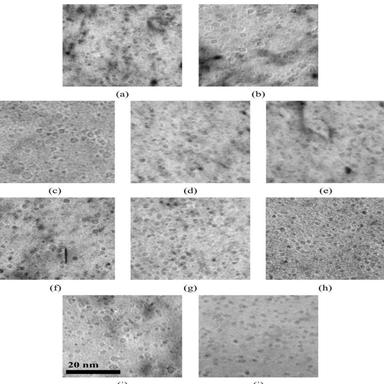
Bright-field micrographs of nanoscale cavities after 150 dpa, dual ion irradiation: stainless steels (a) 316L and (b) 310; precipitate-strengthened, Ni-base alloys (c) X750, (d) 718, and (e) 725; solid solution, Ni-base alloys (f) 690, (g) 625, and (h) C22; and ferritic alloys (i) T92 and (j) 14YWT. Micrographs were recorded using through-focus imaging, although only over-focus (þ250 nm) frames are presented here.